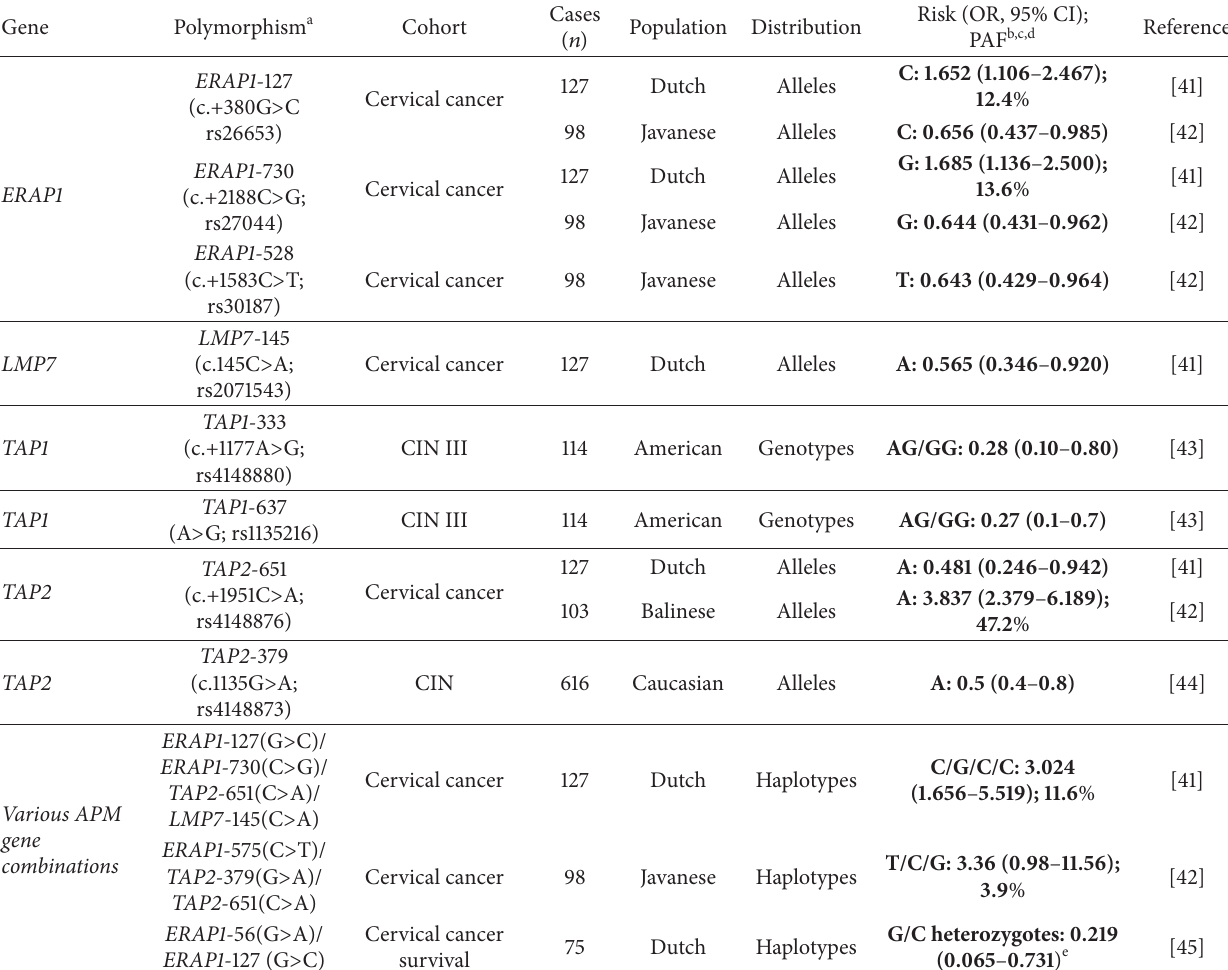
Table 6: Overview of polymorphisms in genes encoding antigen processing machinery components and association with cervical neoplasia